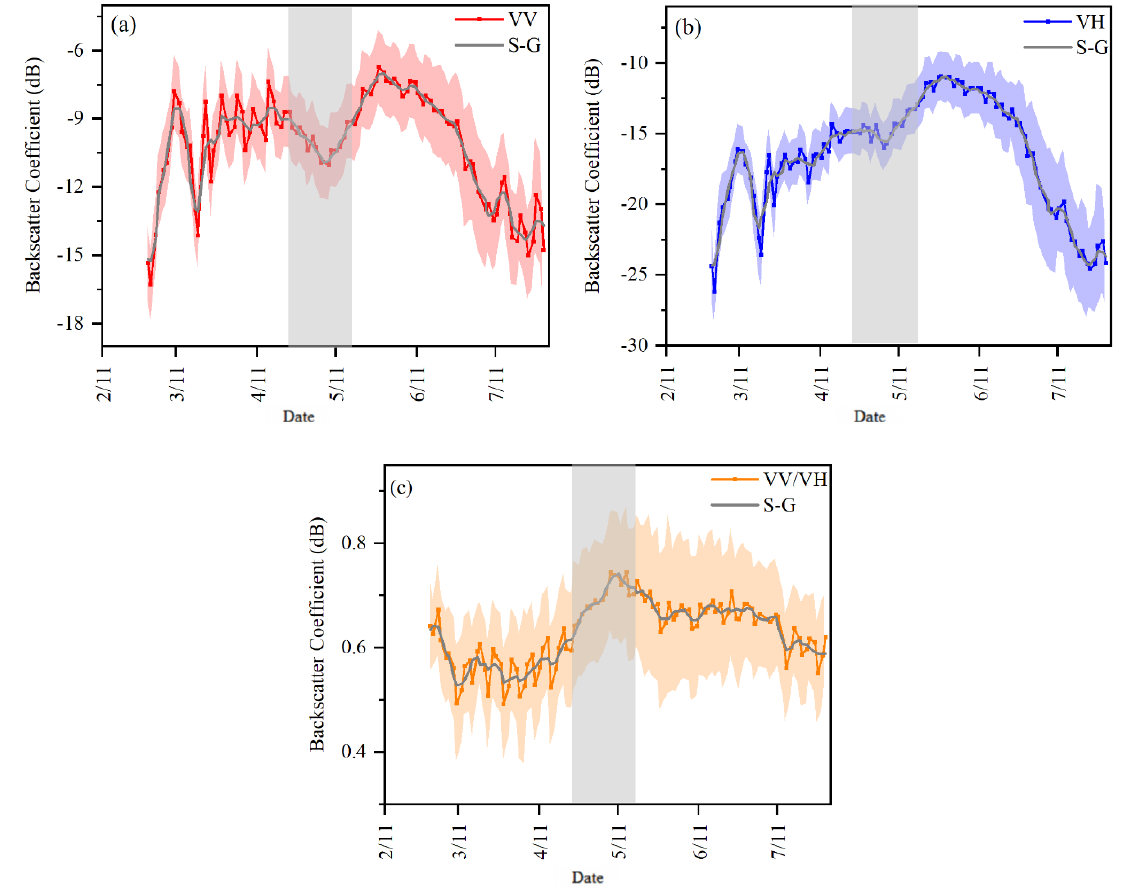
Figure 6. The time series of VV ( a ), VH ( b ), and VV/VH ( c ). The gray area indicates the flowering dates recorded by the DWD. Dots indicate the means and the color-filled area indicates the standard deviations across the 718 parcels.